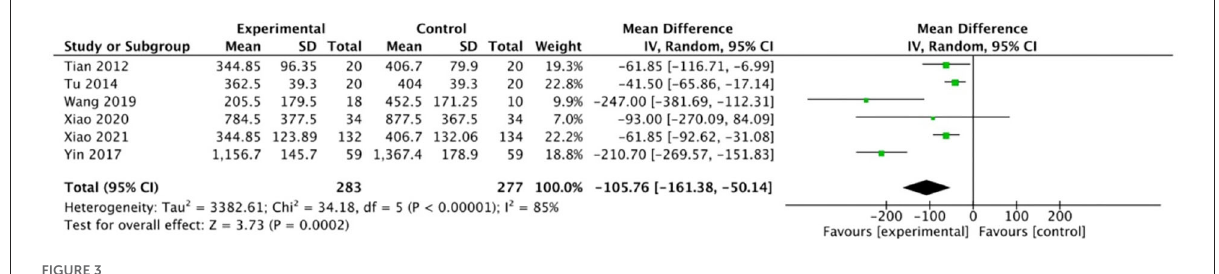
FIGURE3 WOMAC total score.